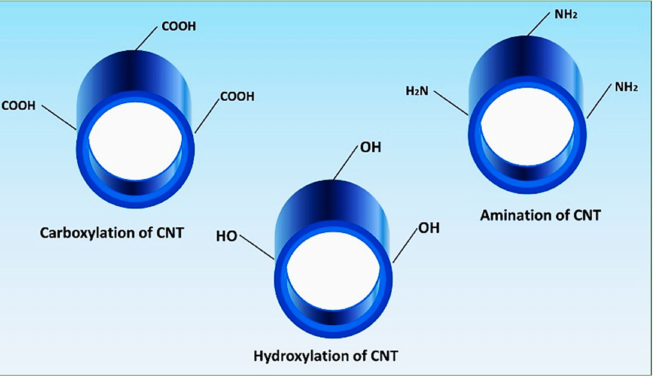
Figure 2. Different types of chemical surface functionalization of CNTs. Reprinted with permis- sion from